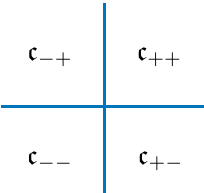
R 2 for two 1 ; m 2 ) 2 t f =